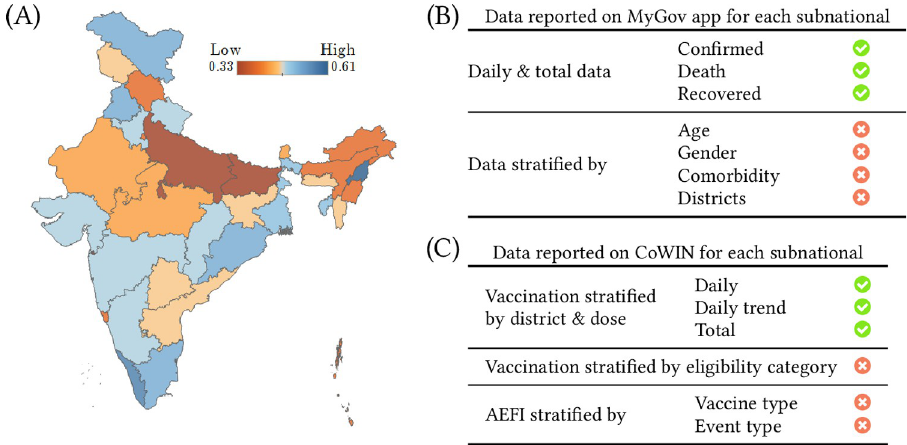
Fig 1. (A) Map showing the variation in surveillance reporting score across India. The map was generated using Tableau Desktop software version 2020.2.1 and the boundary information for regions in India was obtained as shapefiles from Datameet (http://projects.datameet.org/maps/). (B) Table indicating what surveillance data is being reported (or not) for each subnational on the MyGov app. (C) Table indicating the vaccination data reported (or not) for each subnational on the CoWIN